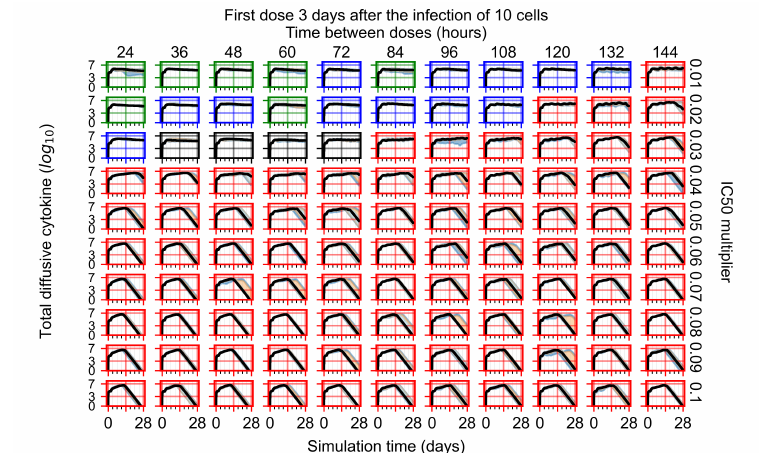
Figure A63. Diffusive cytokine amount, Y axis in log scale, and exponent values as tick marks.